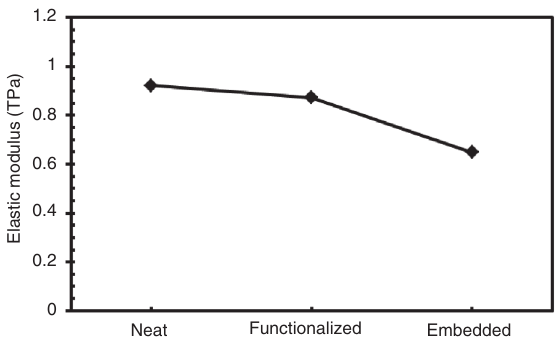
Figure 5 Elastic properties of various single-walled nanotube ensembles [37].